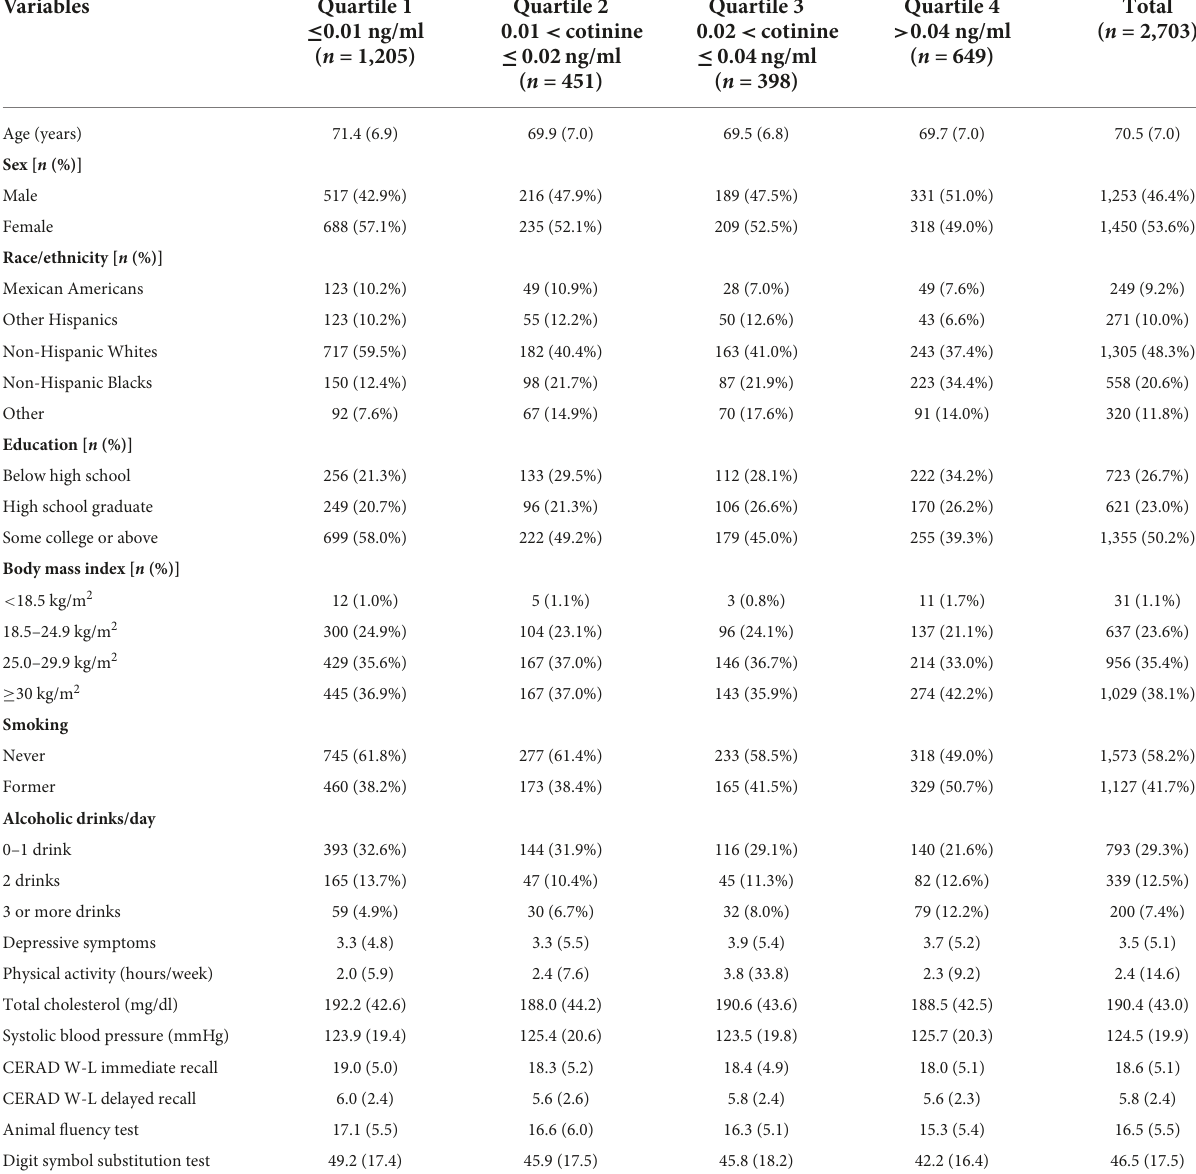
TABLE 1 Characteristics of the participants by quartile of serum cotinine level a .